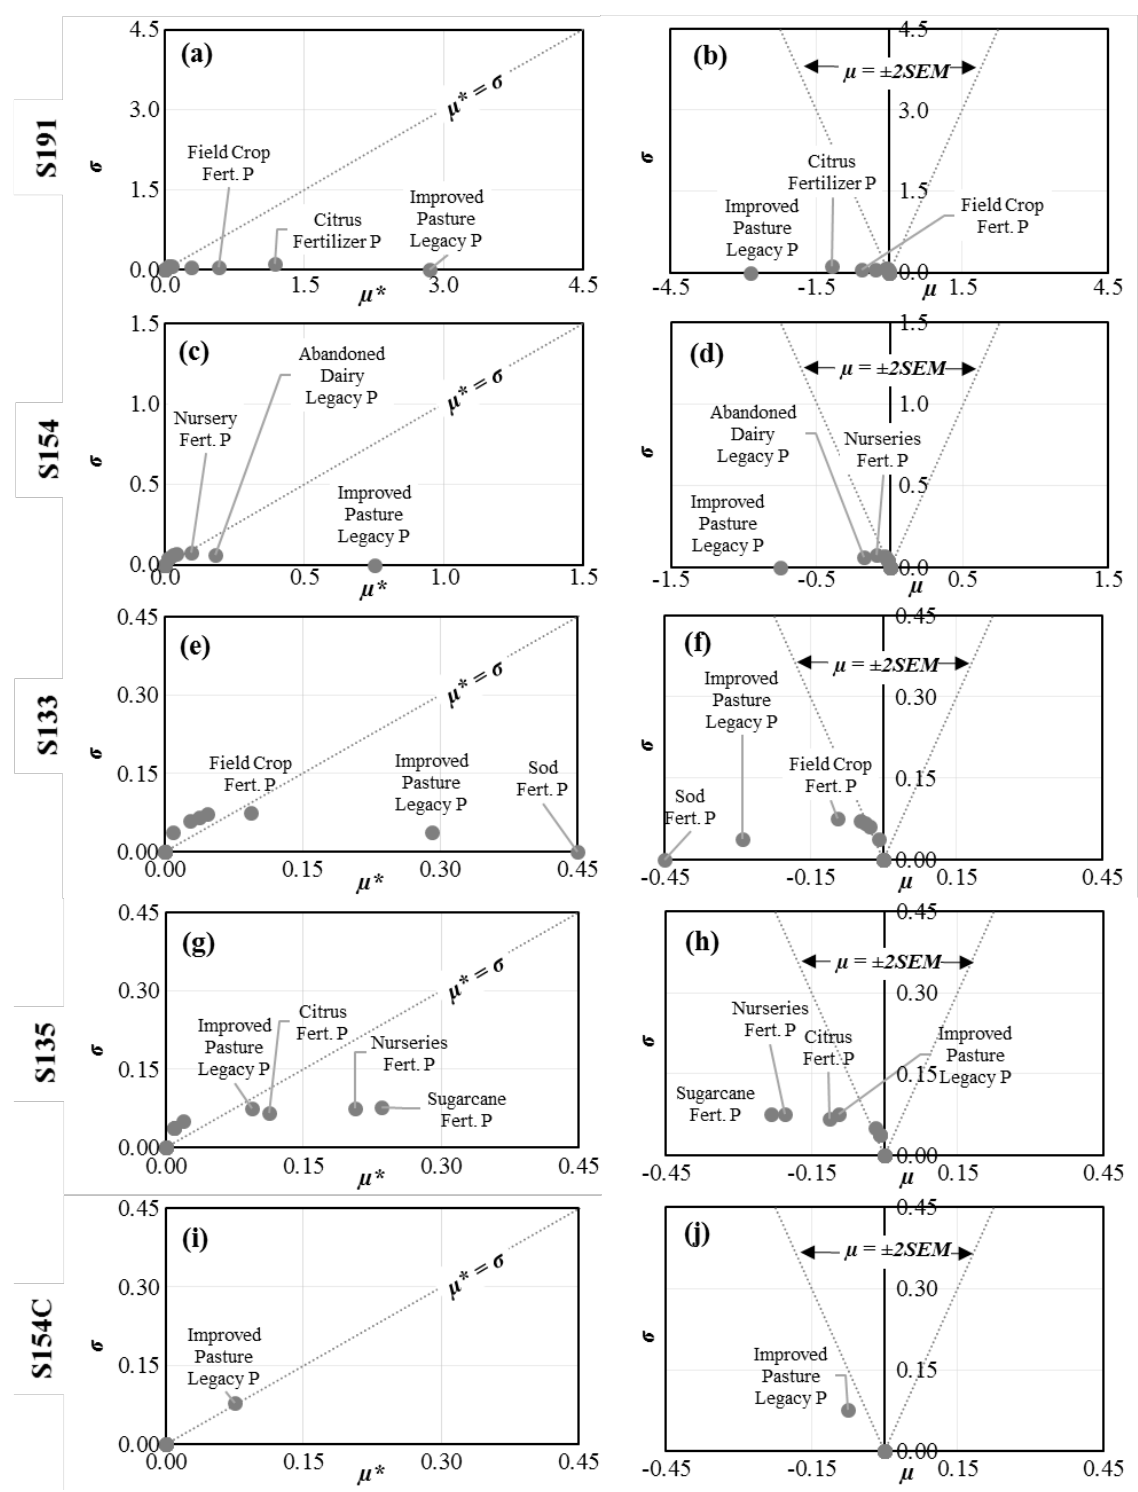
Figure 4. The Morris method GSA results summary for the TCNS basins, ( a ) S191 in µ* − σ space, ( b ) S191 in µ − σ space, ( c ) S154 in µ* − σ space, ( d ) S154 in µ − σ space, ( e ) S133 in µ* − σ space, ( f ) S133 in µ − σ space, ( g ) S135 in µ* − σ space, ( h ) S135 in µ − σ space, ( i ) S154C in µ* − σ space, and ( j ) S154C in µ − σ space.